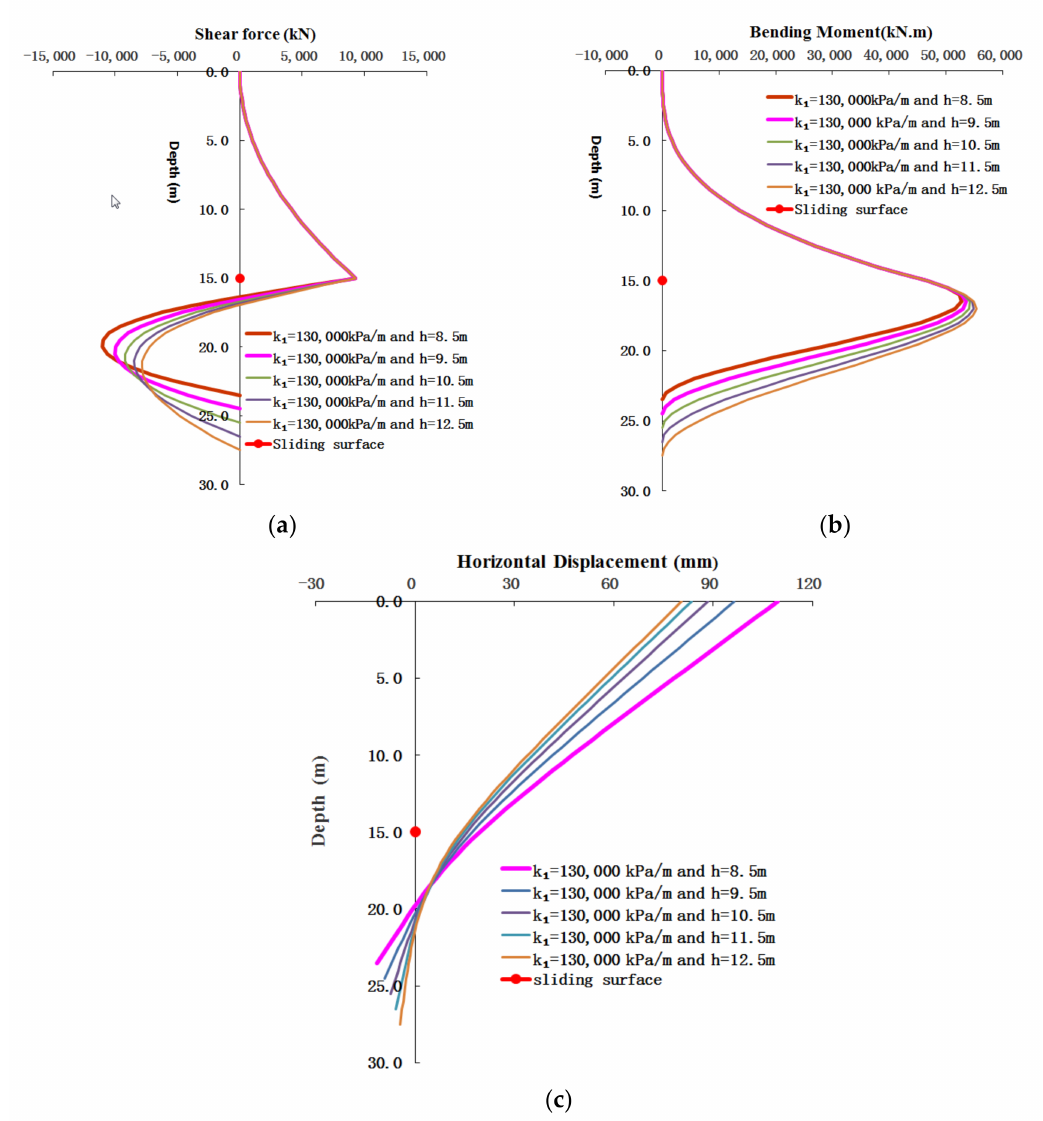
Figure 10. Calculated values of internal forces for piles of various embedded lengths with k 1 = 130,000 kPa / m: ( a ) shear force; ( b ) bending moment; ( c ) horizontal